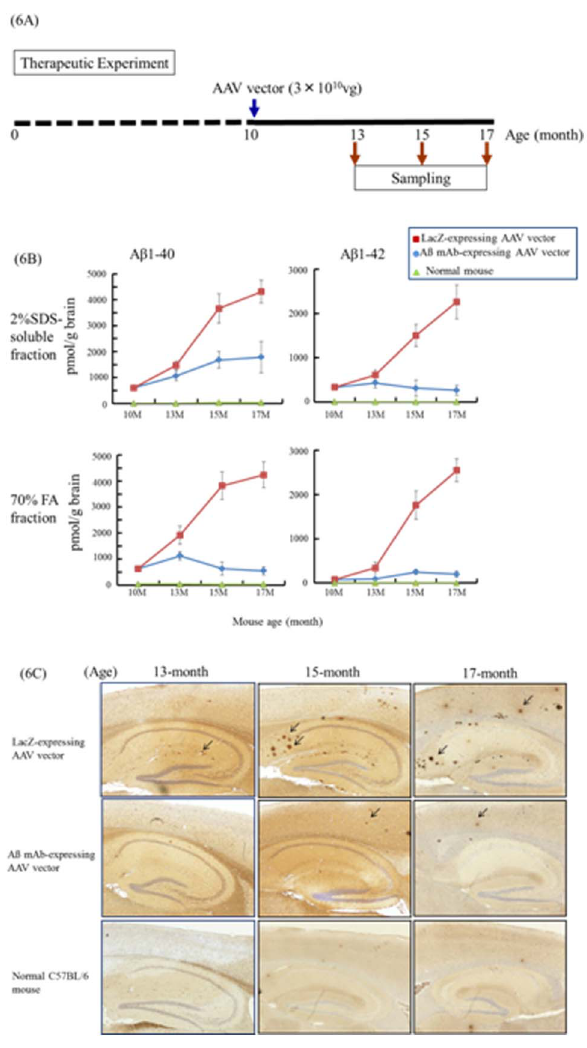
Figure 6. Therapy of AD using Aß mAb-expressing AAV vector. Tem-month old Tg2576 mice were injected i.m. with 3.0 6 10 10 vg of the Aß mAb - expressing AAV vector. (A) Scheme of experiment. (B) The amount of Aß protein in brain extracts was determined using anti-Aß Ab-coated ELISA plates at age 10-, 13-, 15- and 17-month old (4–5 mice per time point). C57BL/6 mice were used as controls. Data are presented as mean 6 SE. (C) Brain sections from Tg2576 or C57BL/6 mice were examined for Aß deposits by immunohistostaining using rabbit anti-human beta amyloid 1–42 polyclonal antibody.